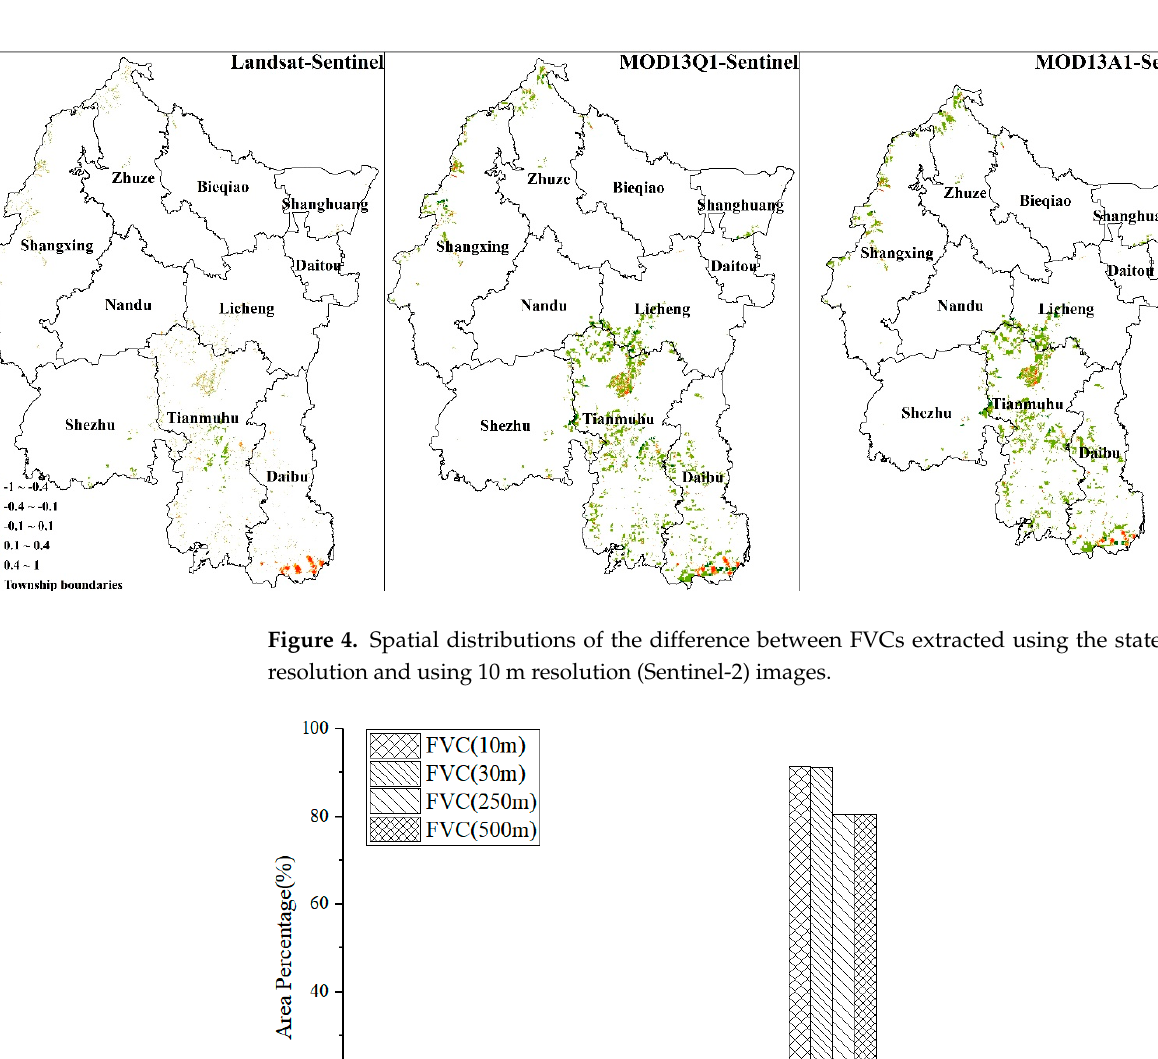
Figure 4. Spatial distributions of the difference between FVCs extracted using the stated spatial res- olution and using 10 m resolution (Sentinel-2) images.